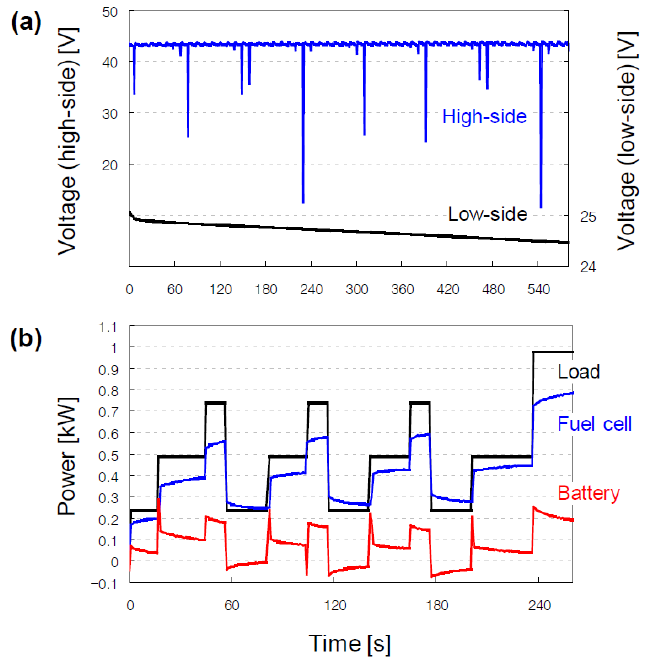
Figure 2. Results of unit tests performed to identify the transient behavior of the entire system and its components. ( a ) Voltage and ( b ) Power versus time.